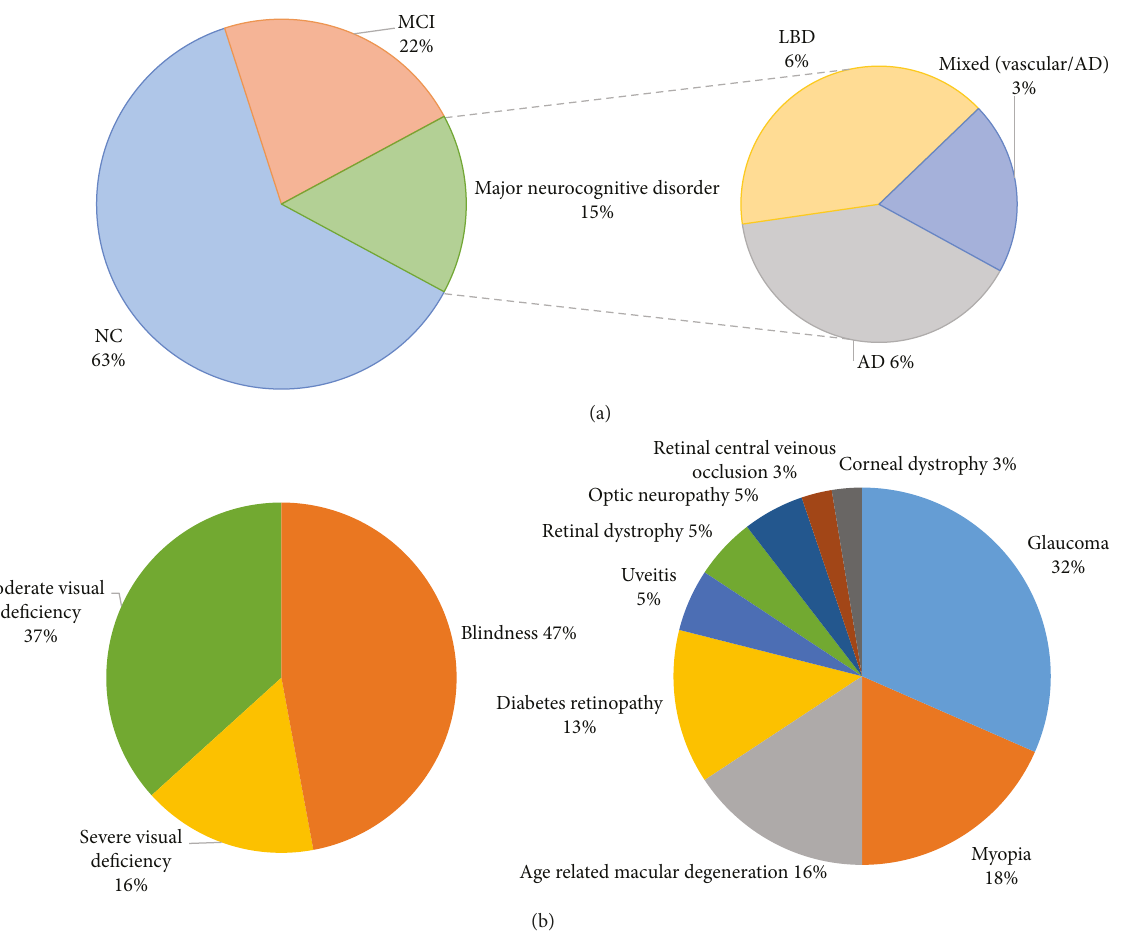
Figure 1: Distribution of the participants according to cognitive status (a) or visual status (b). AD: Alzheimer ’ s disease; LBD: Lewy body dementia; MCI: mild cognitive impairment; NC: normal